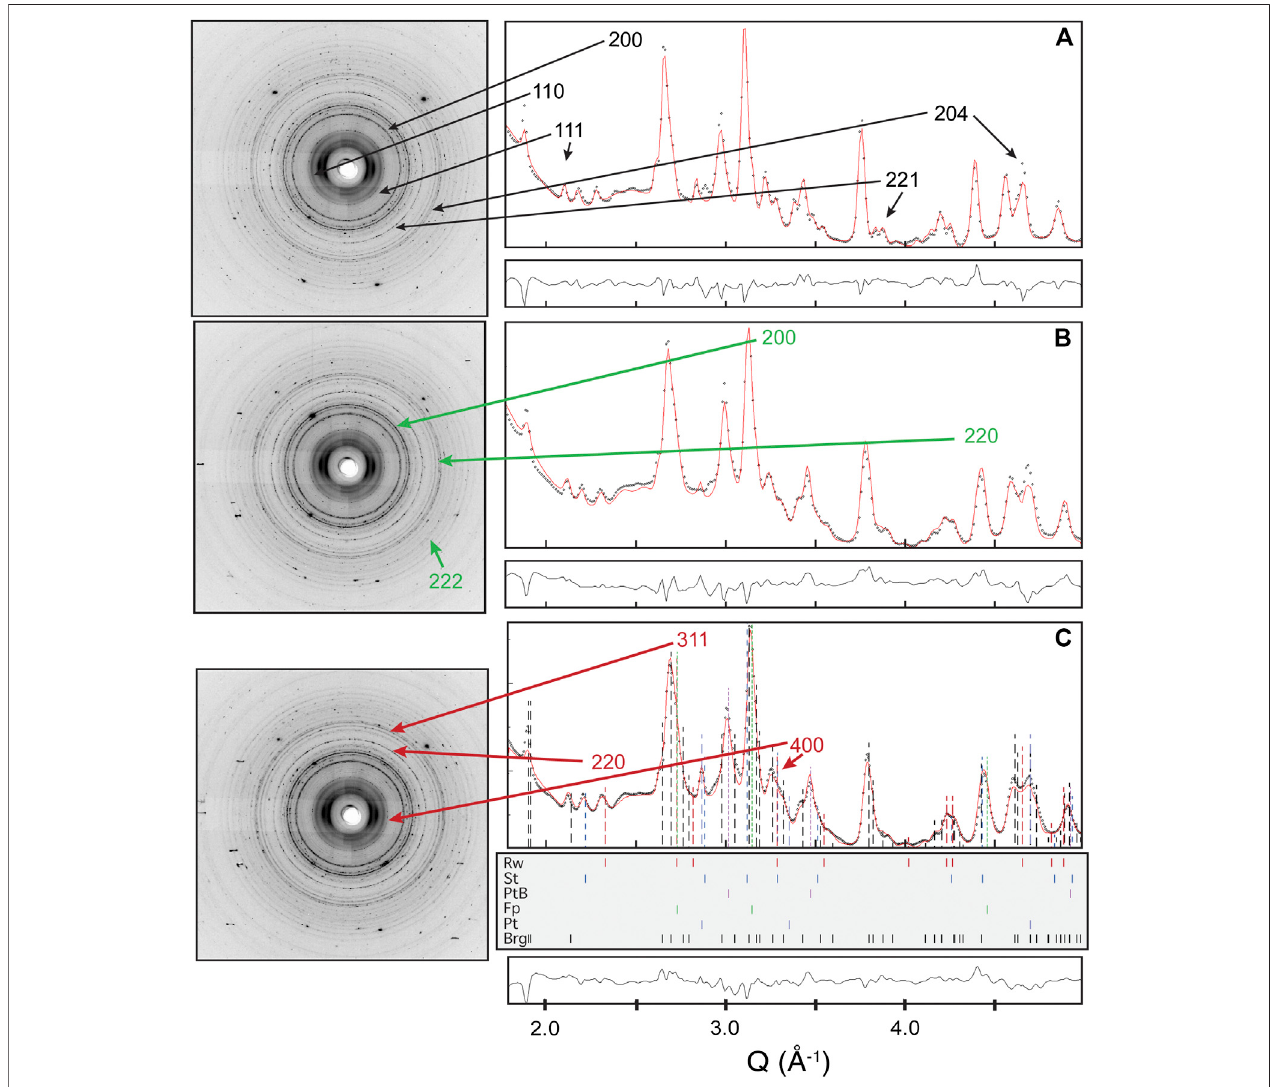
FIGURE1| Diffraction images (left) and Rietveld re fi nement fi tsforthe averageofall 5 ° spectra (right) from thesoftware Materials AnalysisUsing Diffraction for (A) image 139 taken after raising the temperature of the converted aggregate to 1,000 K but before additional compression, (B) image 160 showing the partially compressed aggregate, and (C) image 172 taken at the fi nal stage of compression. Colored, dashed vertical lines of arbitrary height indicate peak locations. Diffraction peaks used for reported Q ( hkl ) for bridgmanite, ferropericlase, and ringwoodite are labeled on plots (A) , (B) , and (C) , respectively.